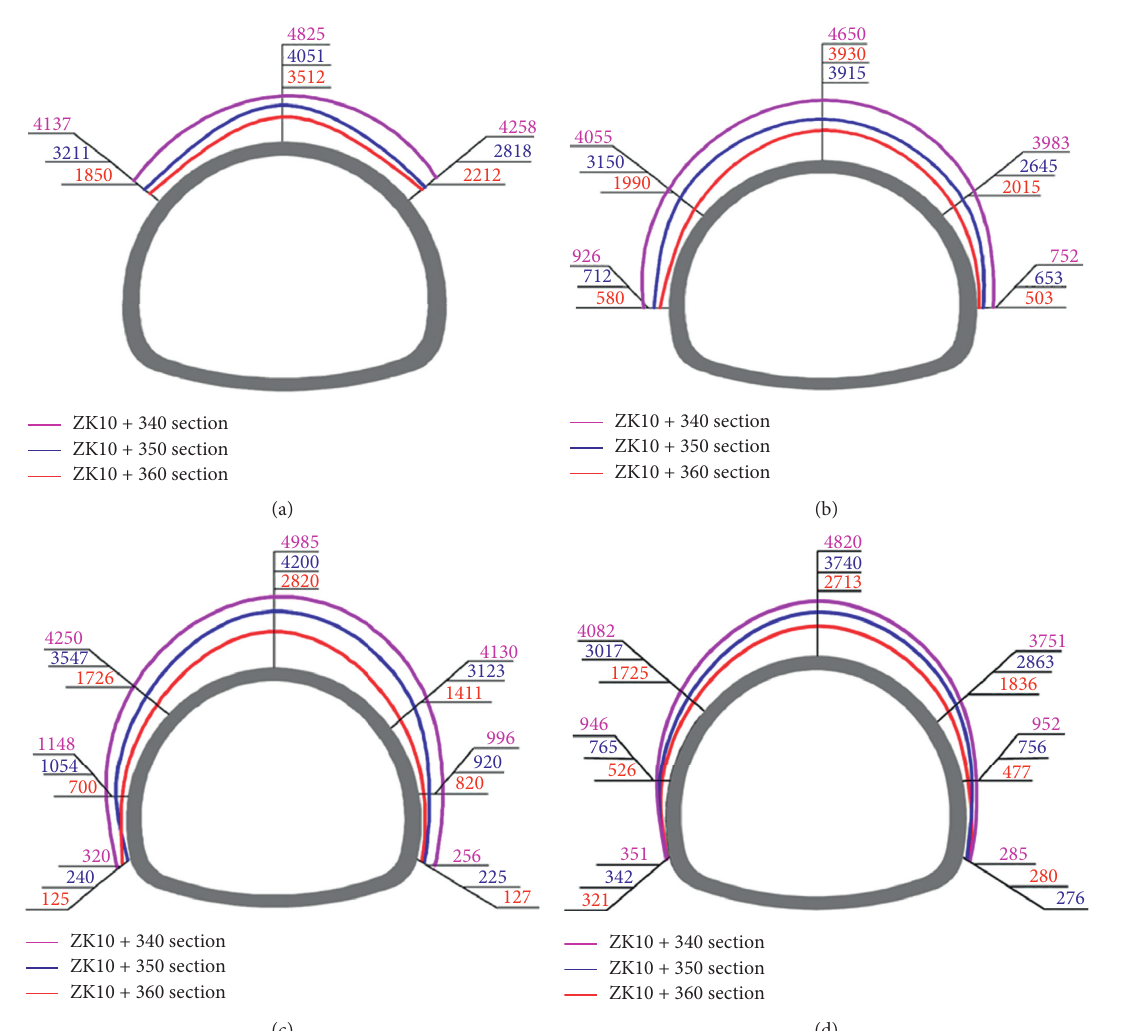
Figure 18: The strain of steel arch of three test sections: (a) after the upper step excavation (unit: με ); (b) after the middle step excavation (unit: με ); (c) after the lower step excavation (unit: με ); (d) after stabilization (unit: με